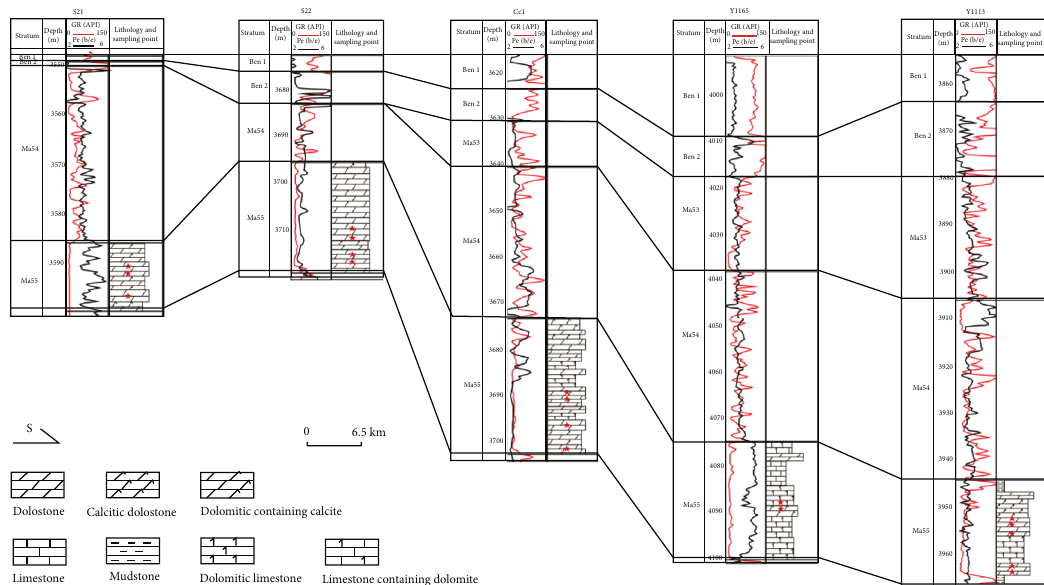
Figure 2: Core well section and sampling points of submember Ma5